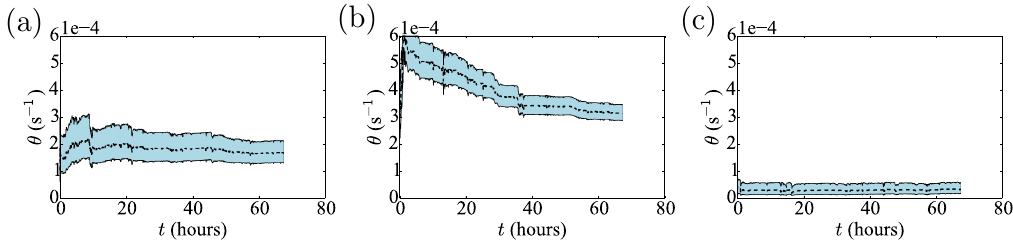
Figure 9. Estimates of the OU rate parameter θ for the ( a ) latitude, ( b ) longitude and ( c ) altitude time-series of a stationary receiver at Port